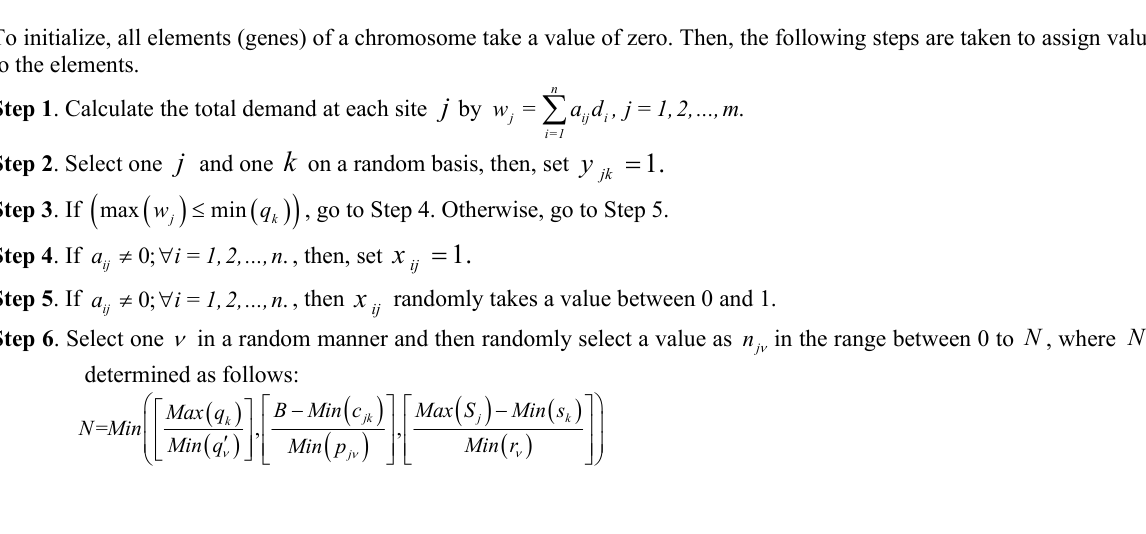
Fig. 2 . The general structure of a chromosome for the proposed